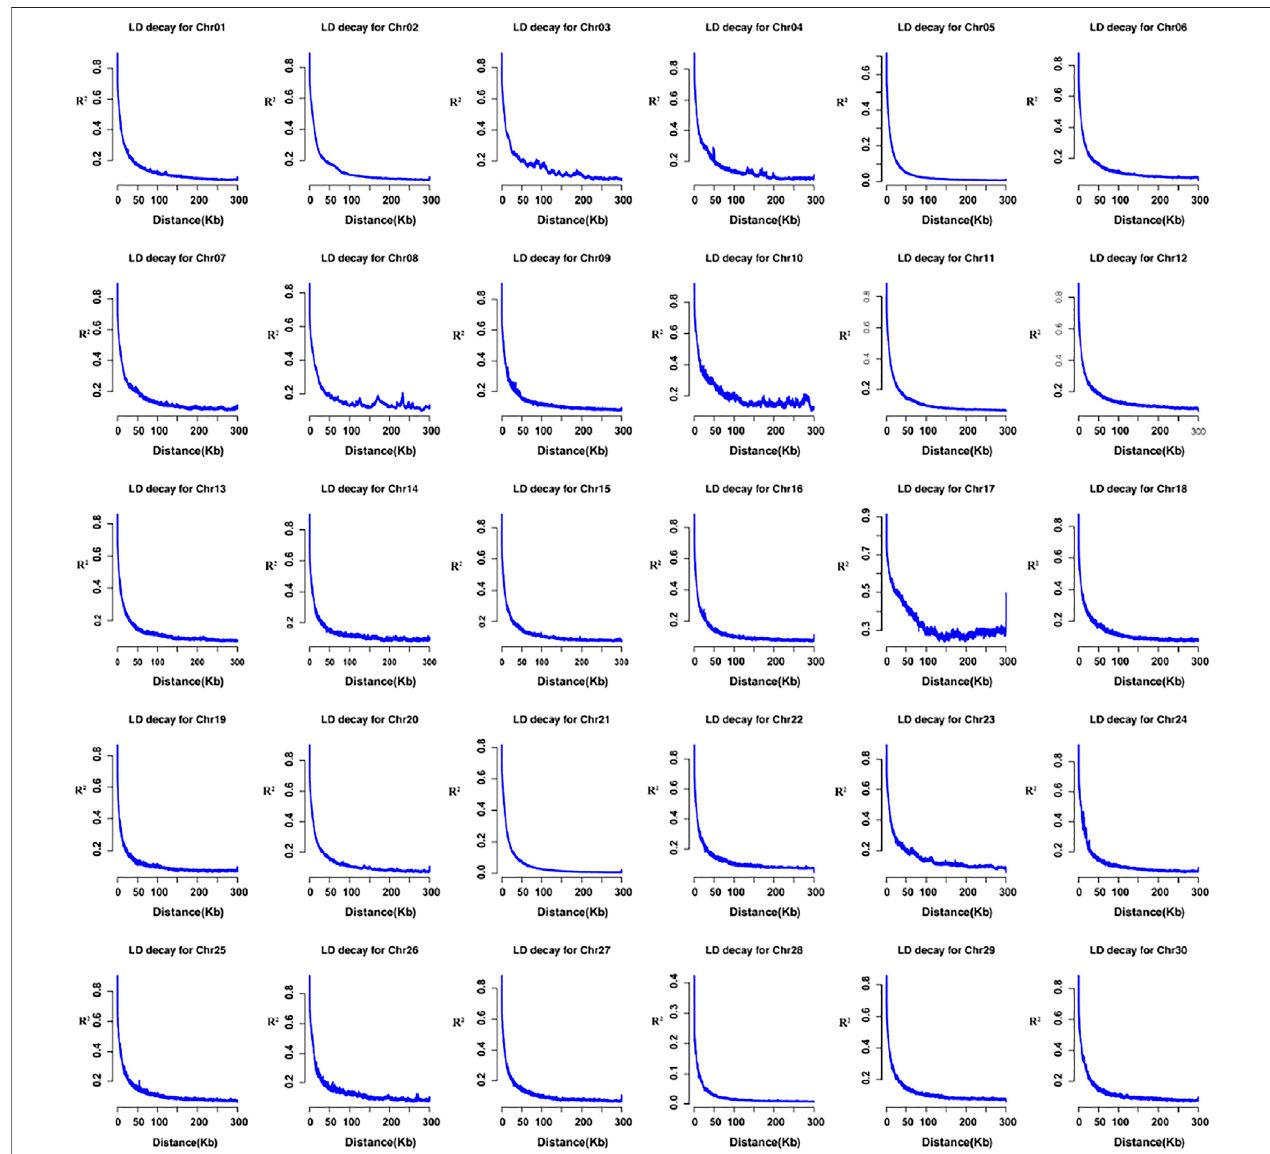
FIGURE 3 | LD decay by chromosome (1-30); the horizontal axis represents the distance (kb), the y-axis shows the pair-wise r 2 values.